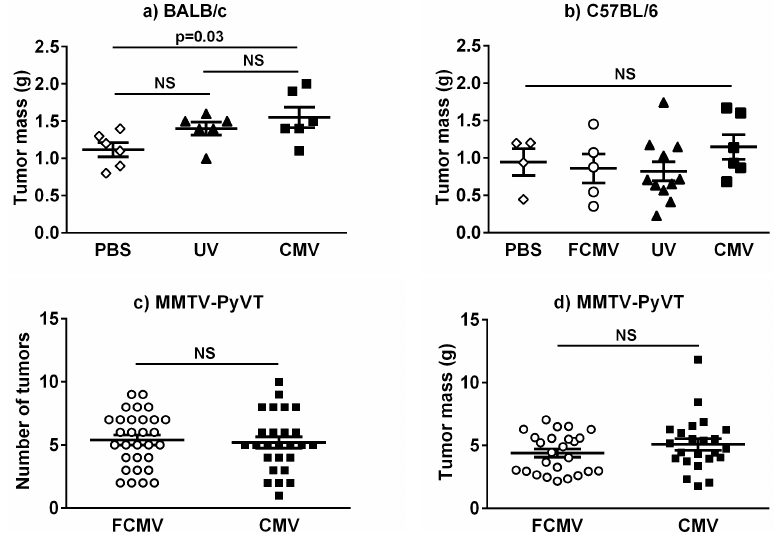
Figure 1. The latent mCMV infection has minimal effects on breast tumor mass. The breast tumor mass was measured at the endpoint in the latent infection models of BALB/c ( a ) and C57BL/6 ( b ) mice, n = 6 and n = 4–11, respectively. The control mice were injected with PBS, UV-inactivated CMV (UV) or a solution where active CMV was filtered out (FCMV). The total number ( c ) and total mass ( d ) of all breast tumors developed in MMTV-PyVT mice were quantified for 25 mice treated with a filtered control solution (FCMV) and for 23 mCMV-infected mice. The p -values were calculated by a one-way ANOVA (Figure 1a,b) or Student’s t -test (Figure 1c,d) with p < 0.05 considered to be significant. NS = not significant.